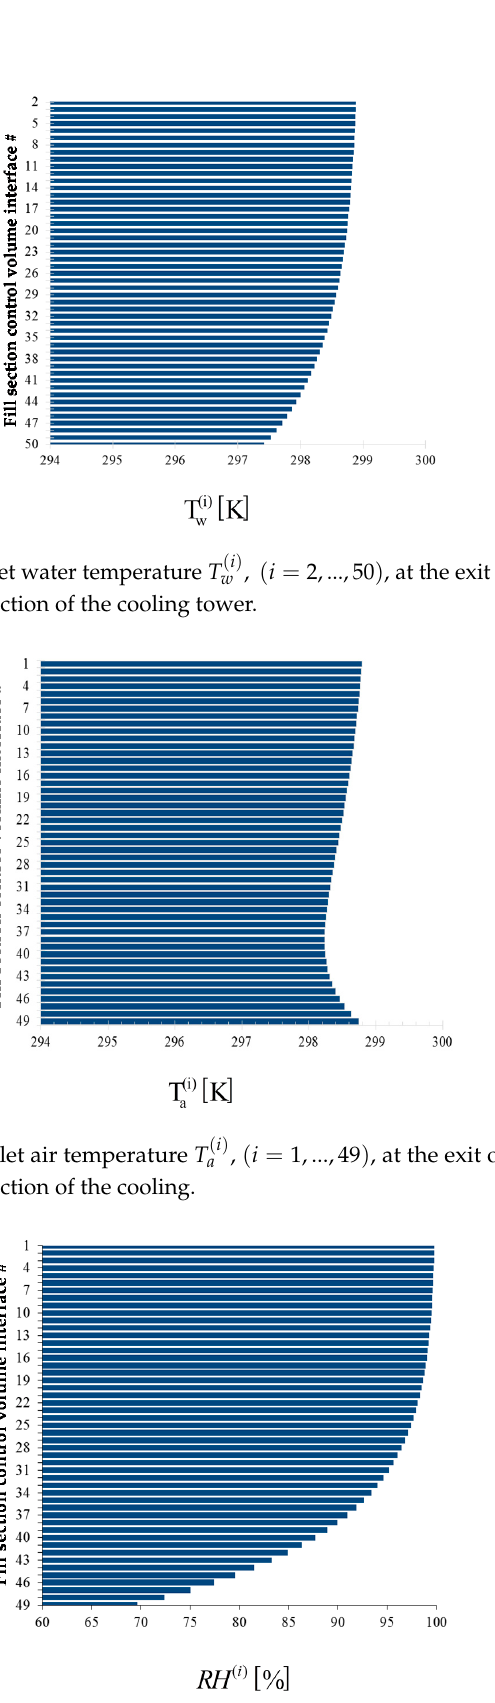
Figure 7. Bar plot of the outlet air relative humidity RH ( i ) , ( i = 1,...,49 ) , at the exit of each control volume along the height of the fill section of the cooling.